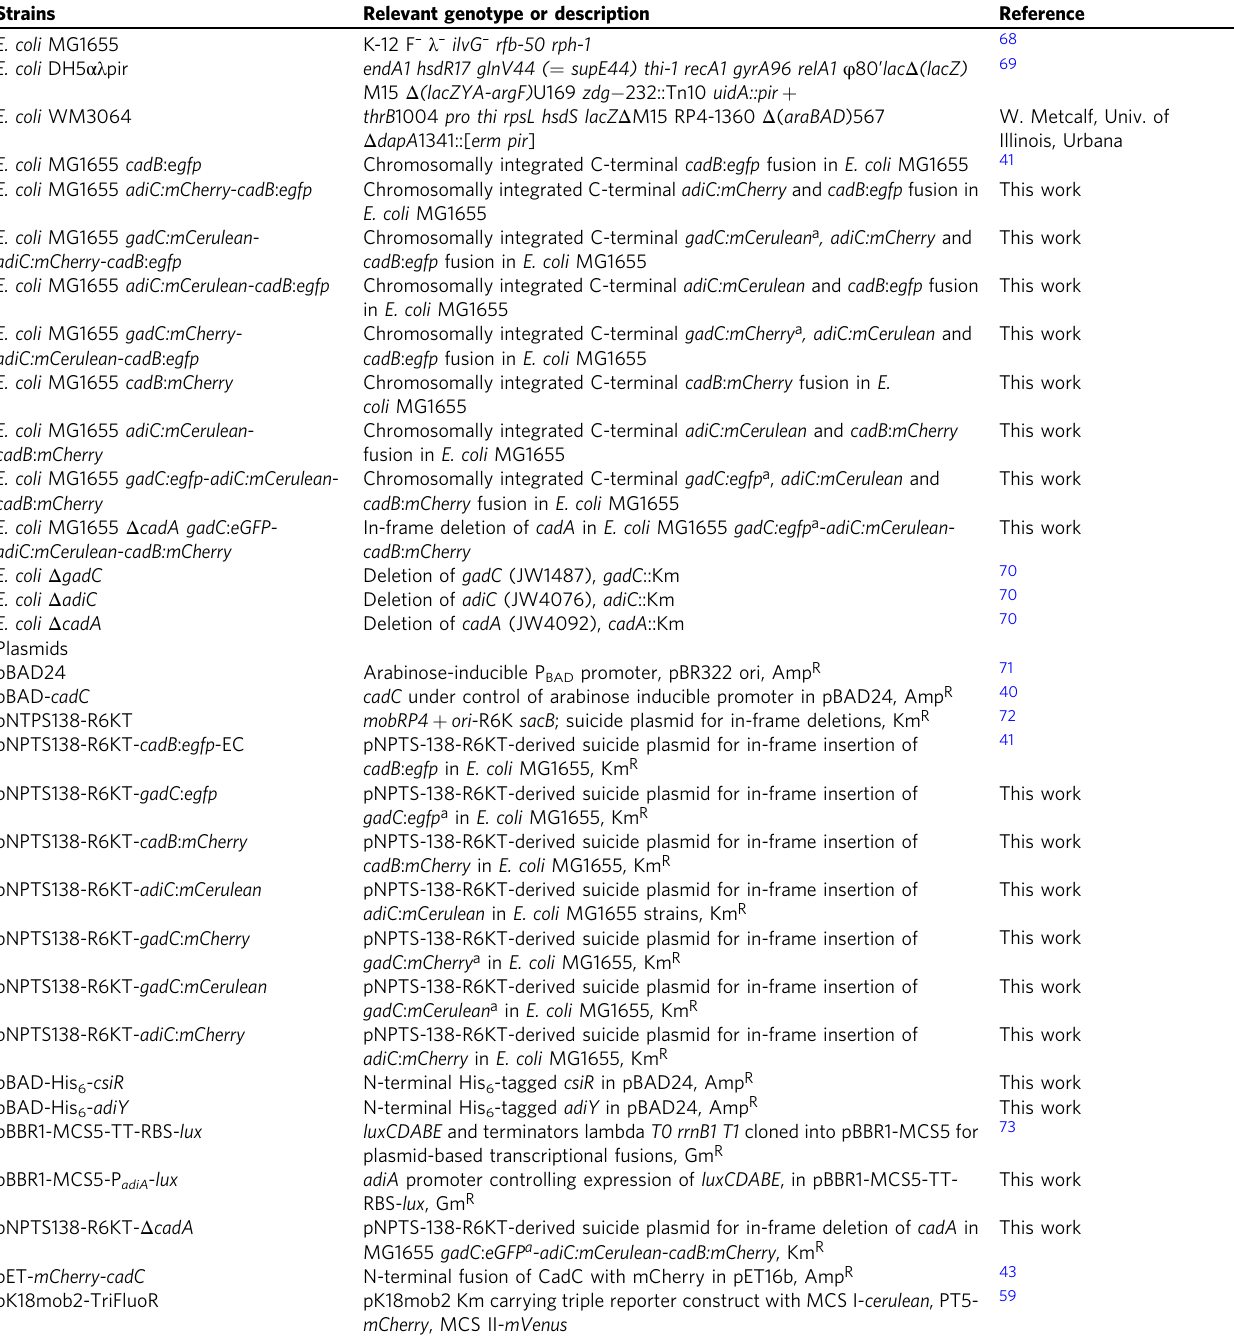
Table 1 Strains and plasmids used in this